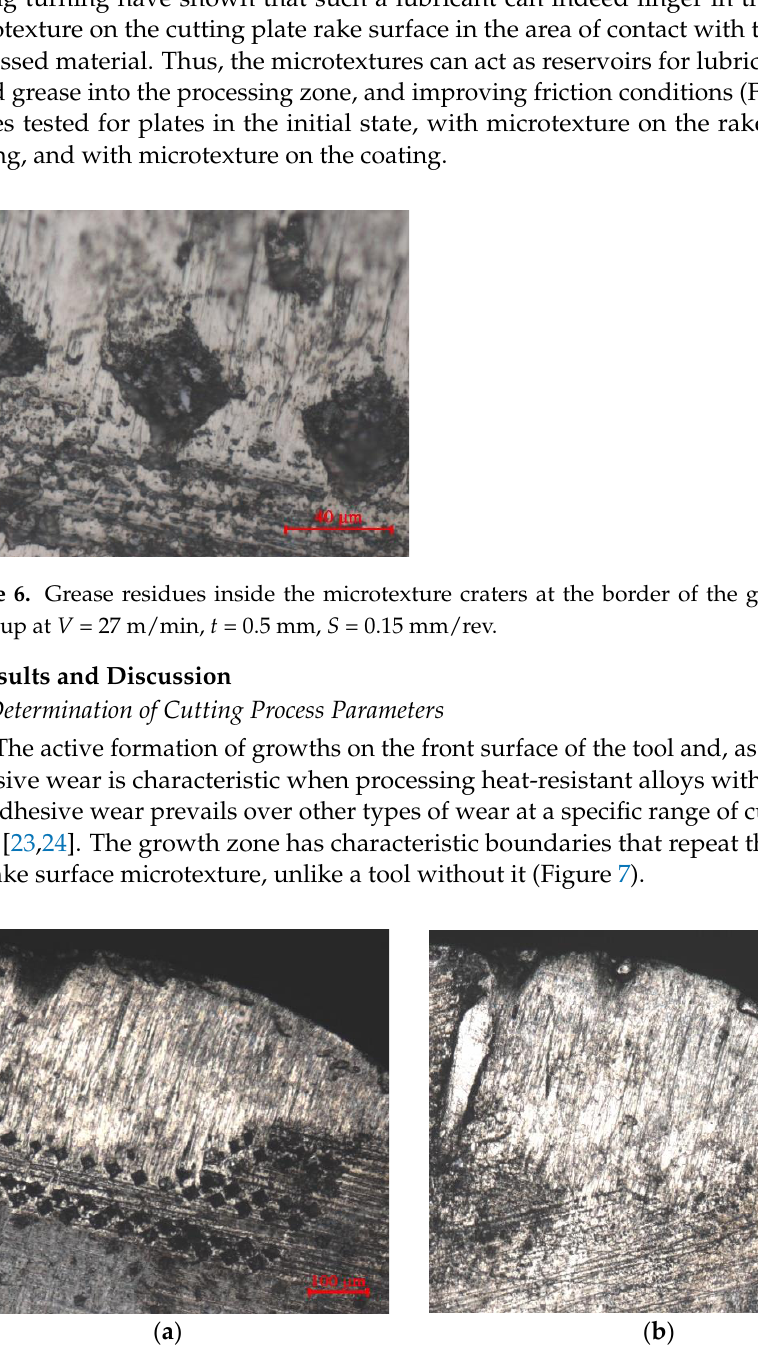
Figure 8. Dependence of the cutting temperature on the cutting depth for various tools at a cutting speed of V = 17 m/min and S = 0.15 mm/rev. On the one hand, the microtexture keeps the lubricant in the cutting zone and thereby affects the friction force and the interaction of the tool and workpiece materials. However, as a rule, wear-resistant coatings have the same effect on the cutting process [25,26]. Namely, they reduce the coefficient of friction and are chemically resistant. On the other hand, it can assume that the company of microtextures contributes to a reduced setting between the material of the workpiece and the tool. It was decided to focus on studying the changes in the tangential component of the cutting force, as a force that indicates the amount of energy transferred from the machine drives to the processing zone to complete the cutting process and chip formation, and this